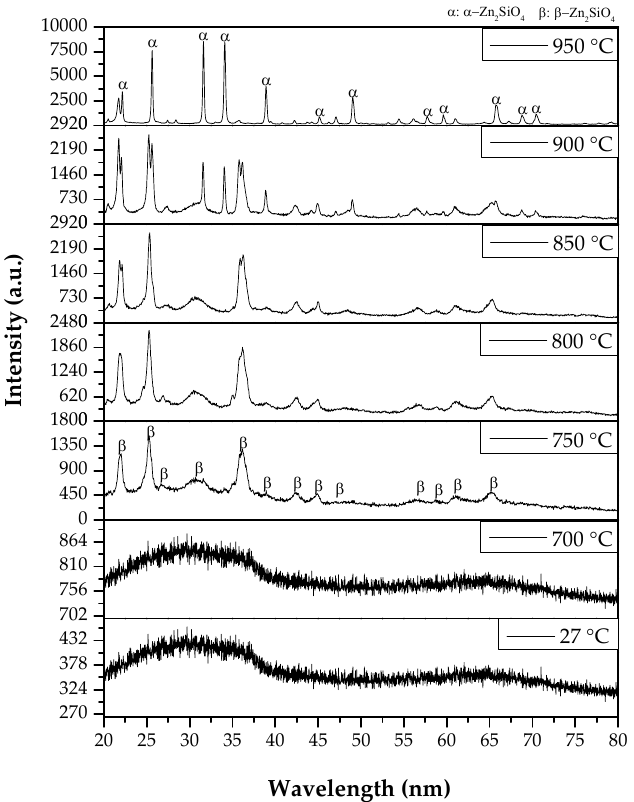
Figure 2. X-ray diffraction patterns of the zinc silicate glass and glass-ceramics that were heat treated at various sintering temperatures .